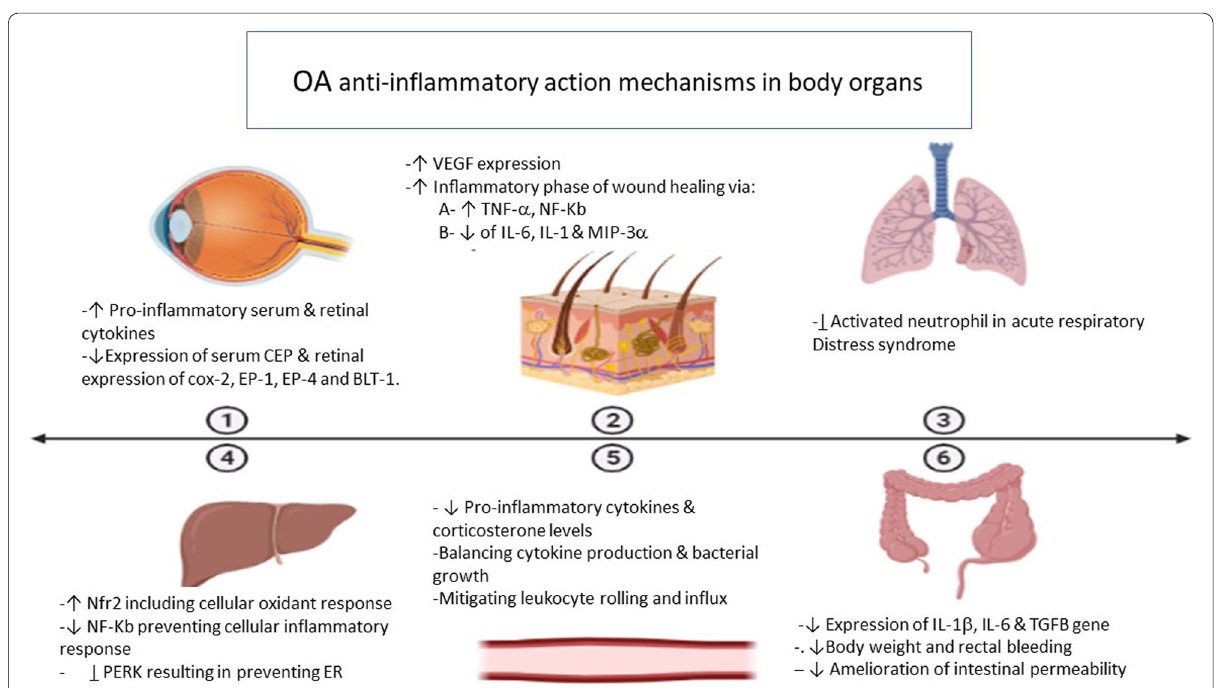
Fig. 3 Oleic acid (OA) anti-inflammatory action mechanisms in the different body organs viz. eye, skin, lung, liver, blood vessels, and